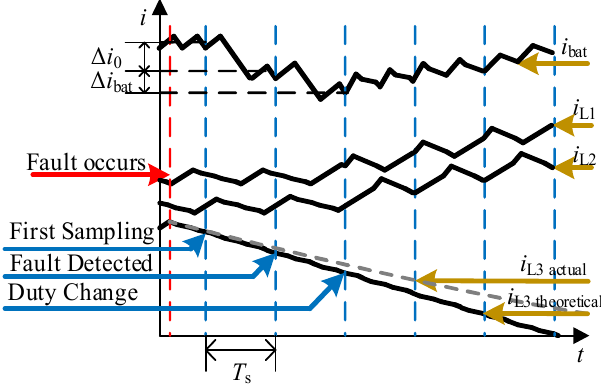
Figure 6. The schematic diagram after compensation added.